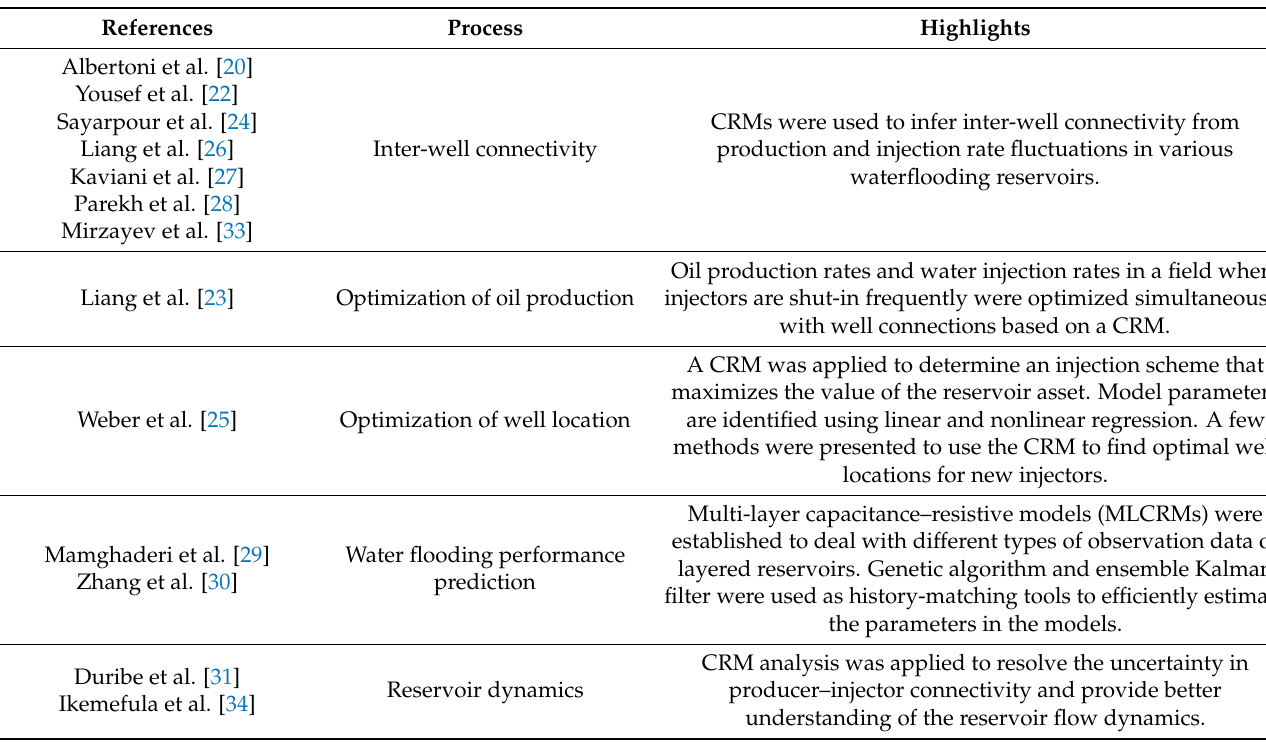
Table 1. Summary of literature review for